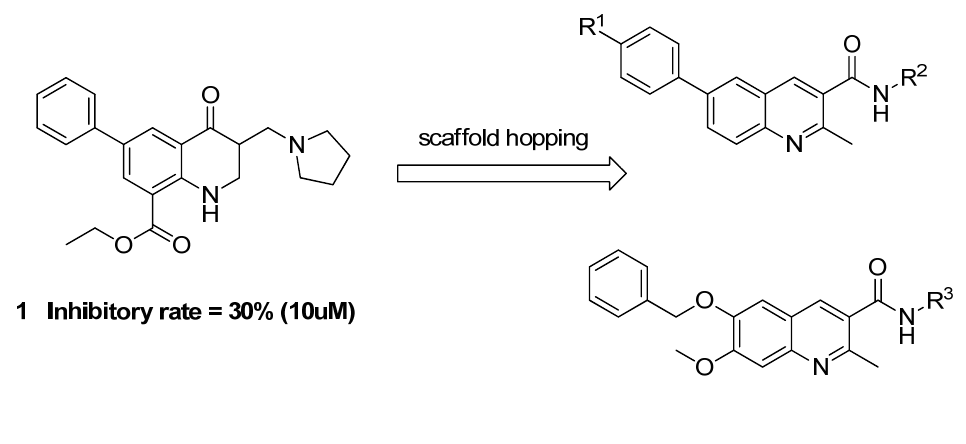
Figure 2. Scaffold hopping from tetrahydroquinolone into quinoline